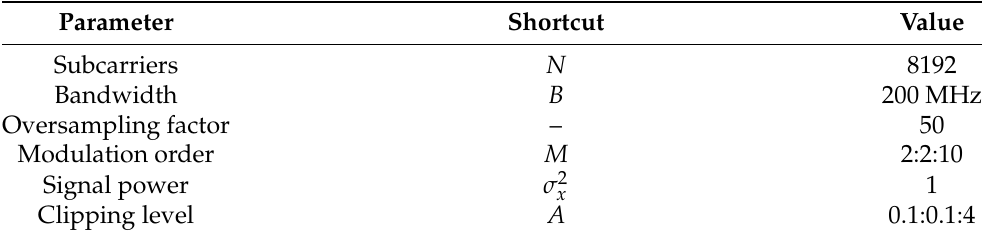
Table 1. Parameters used in this work for the evaluation of the analytical and theoretical expressions, as well as for the Monte Carlo